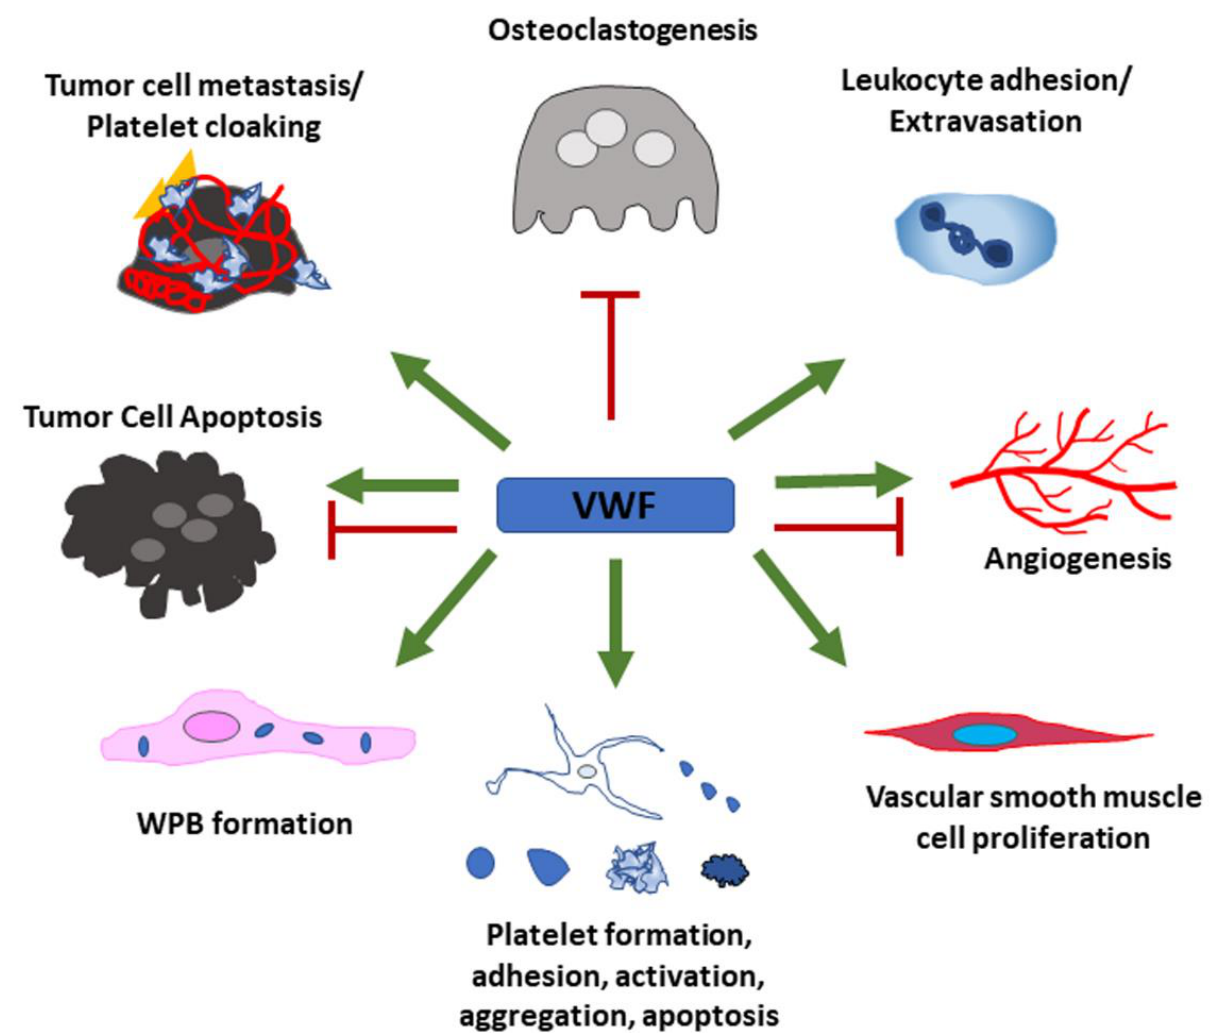
Figure 5. Summary of VWF’s cellular functions. VWF has positive effects (green arrows) on leukocyte adhesion and extravasation, prolifera- tion of vascular smooth muscle cells and Weibel – Palade body formation in endothelial cells. VWF